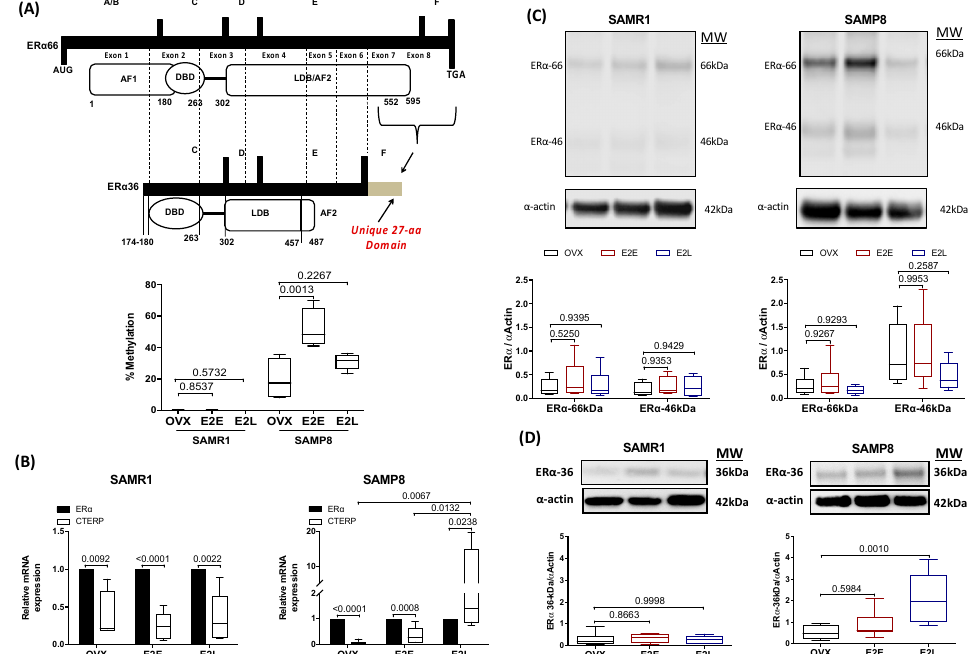
Figure 5. Transcriptional and post-transcriptional regulation of ER α . Percentage of specific DNA methylation in the gene encoding ER α in common carotid artery of SAMR1 and SAMP8 ( A ). Bar graphs show the percentage (%) of methylation in the region comprised between exon 7 and exon 8 and translated to the C-terminus. mRNA expression of C-terminally truncated ER α product (CTERP) relative to the expression of wild-type (ER α 66) in mice carotid ( B ) . Protein expression of the classical ER α 66 and the alternative splicing variants ER α 46 ( C ) and ER α 36 ( D ) in common carotid normalized by the expression of α -actin. Samples of genomic DNA, total RNA or protein were obtained in vessels from untreated ovariectomized mice (OVX), ovariectomized mice under early-onset (E 2 E) or late-onset (E 2 L) of 17 β -estradiol treatment. Each point represents the mean ± SEM from 5–7 independent experiments. One-way ANOVA analyzed the dependence of data on the onset of estrogen therapy (none, early, or late) in SAMR1 or SAMP8 with Bonferroni’s post-test. p -values and comparisons are expressed on top of bar graphs. Significance is considered when p <